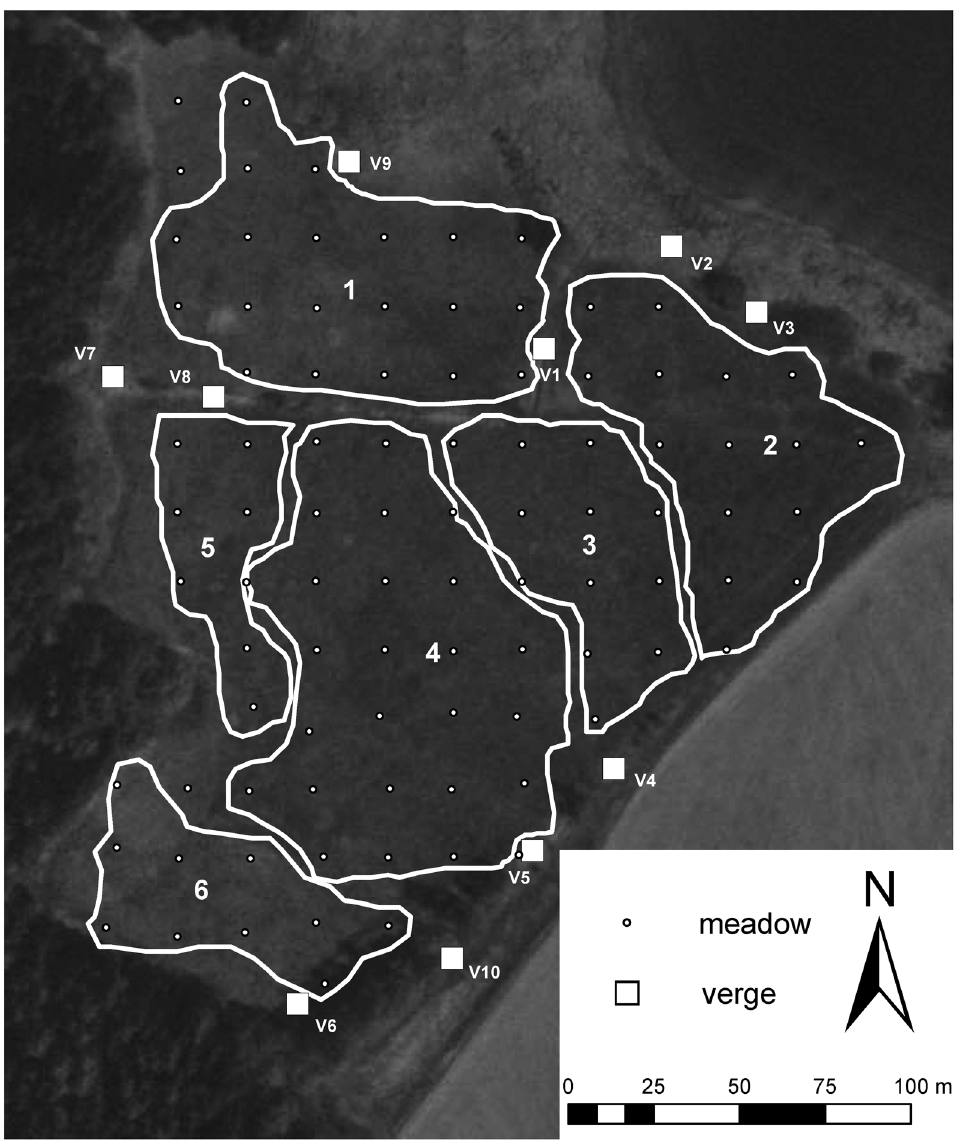
Figure 1. Delimitation of the meadow sectors according to plant community composition. Sectors: 1 – wet, nutrient-poor stands; 2 – mesic to intermittently wet, nutrient-rich stands; 3 – intermittently wet, nutrient moderately rich stands; 4 – mesic, nutrient-rich stands; 5 – moderately wet, nutrient moderately rich stands; 6 – very wet, nutrient moderately rich stand;(for information on flowering plant composition please refer to File S1: Table S4). Aerial photograph credit: Czech Office for Surveying, Mapping and